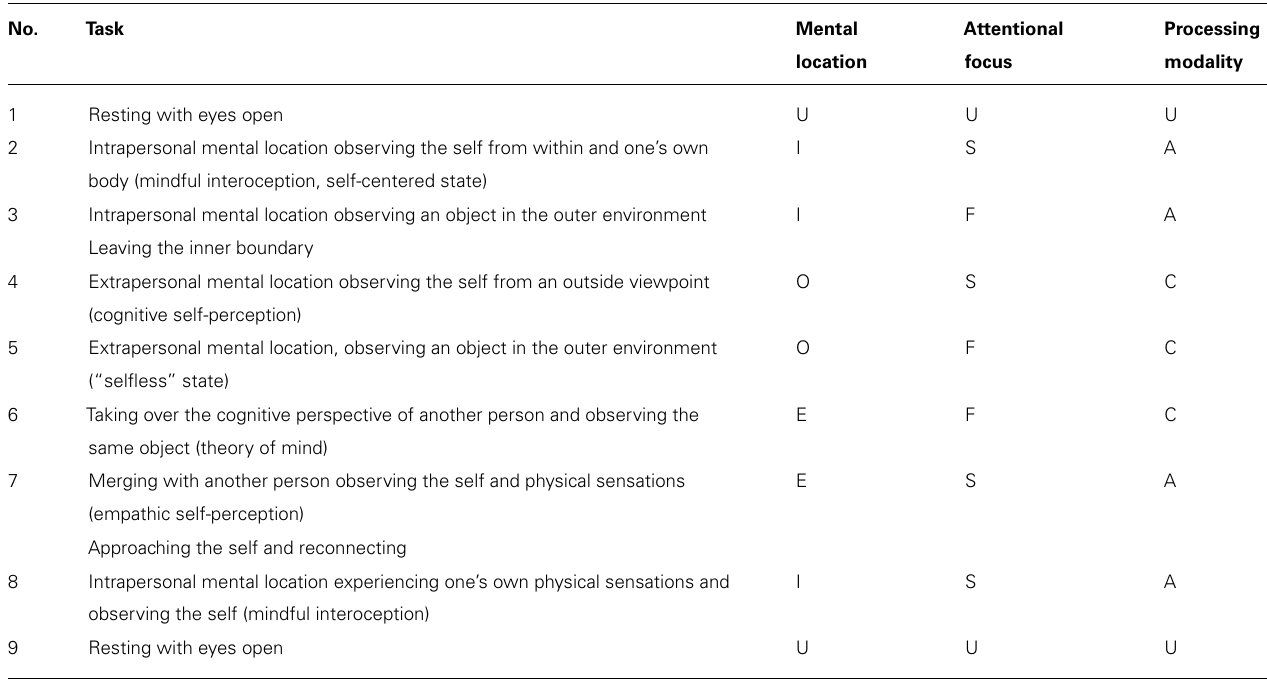
Attentional Processing location focus modality